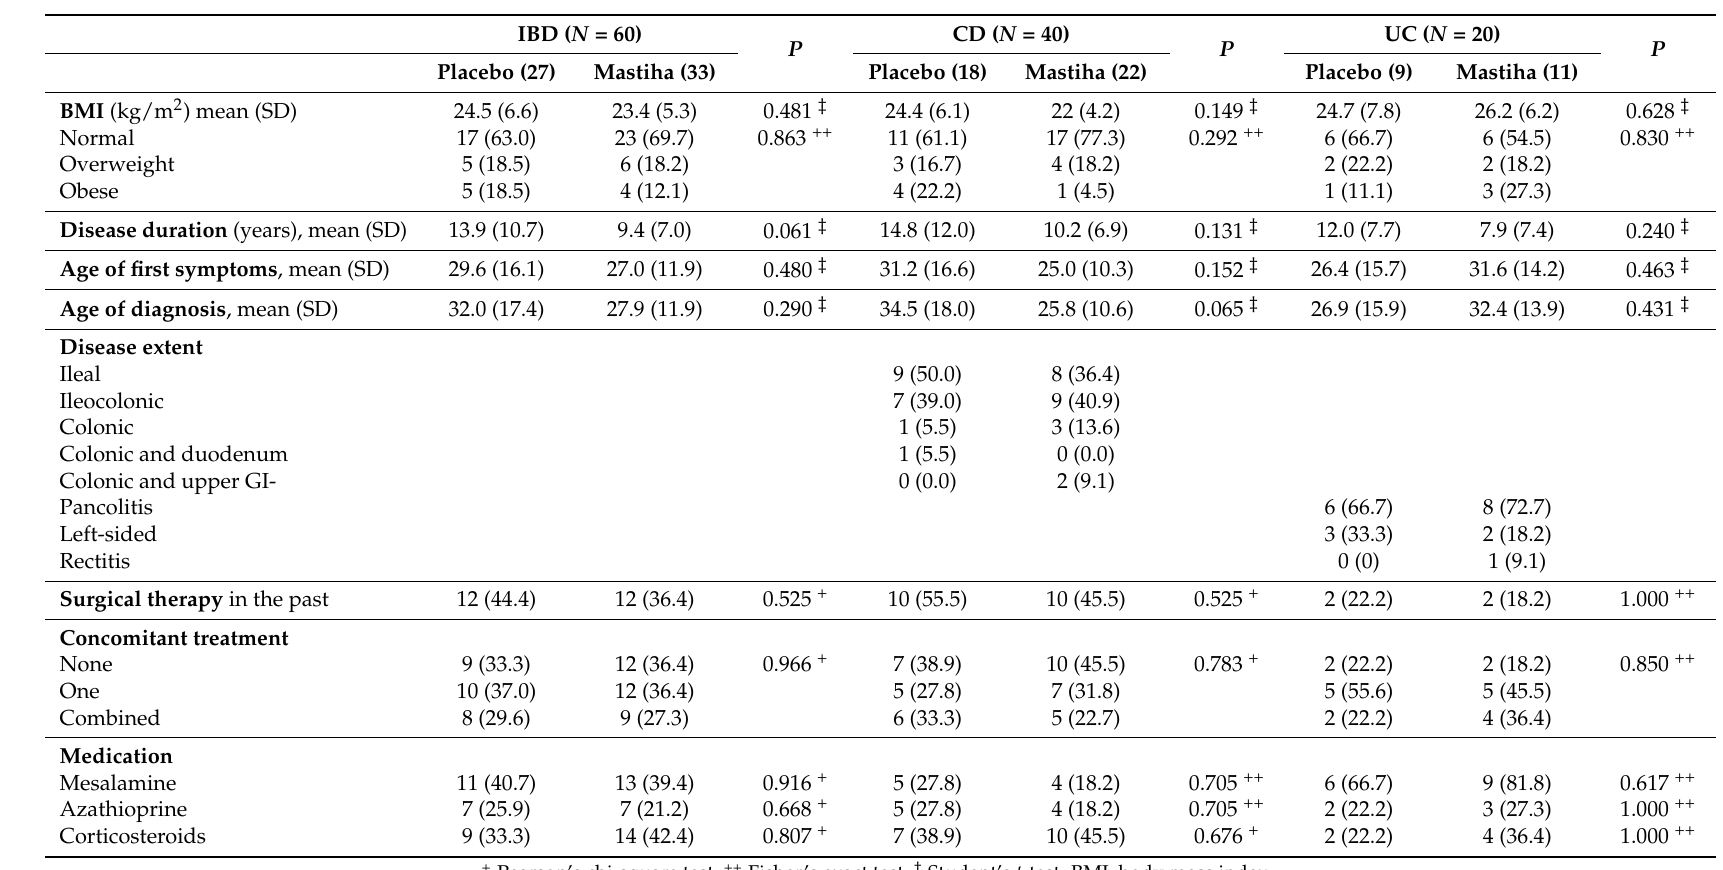
Table 2. Anthropometrics and clinical characteristics in IBD patients. The results are given as N (%) of the total